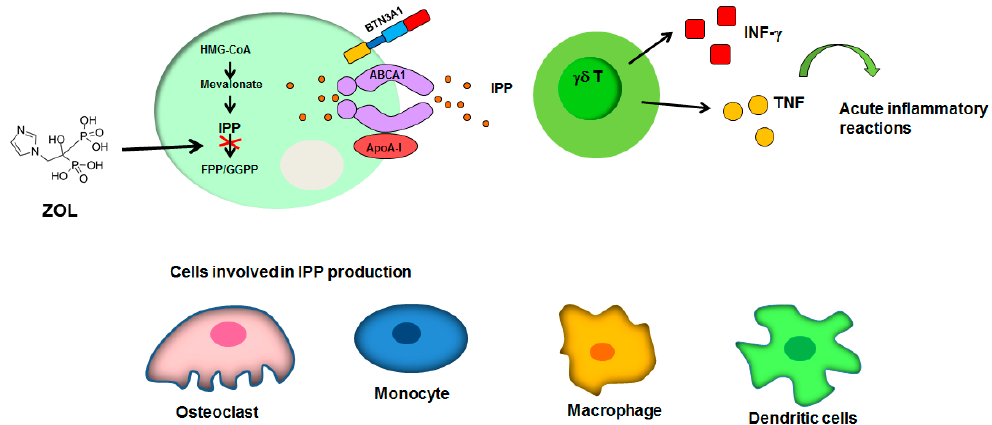
Figure 2. Mechanisms of γδ T-cells activation. The ZOL-mediated overproduction of IPP in osteoclasts